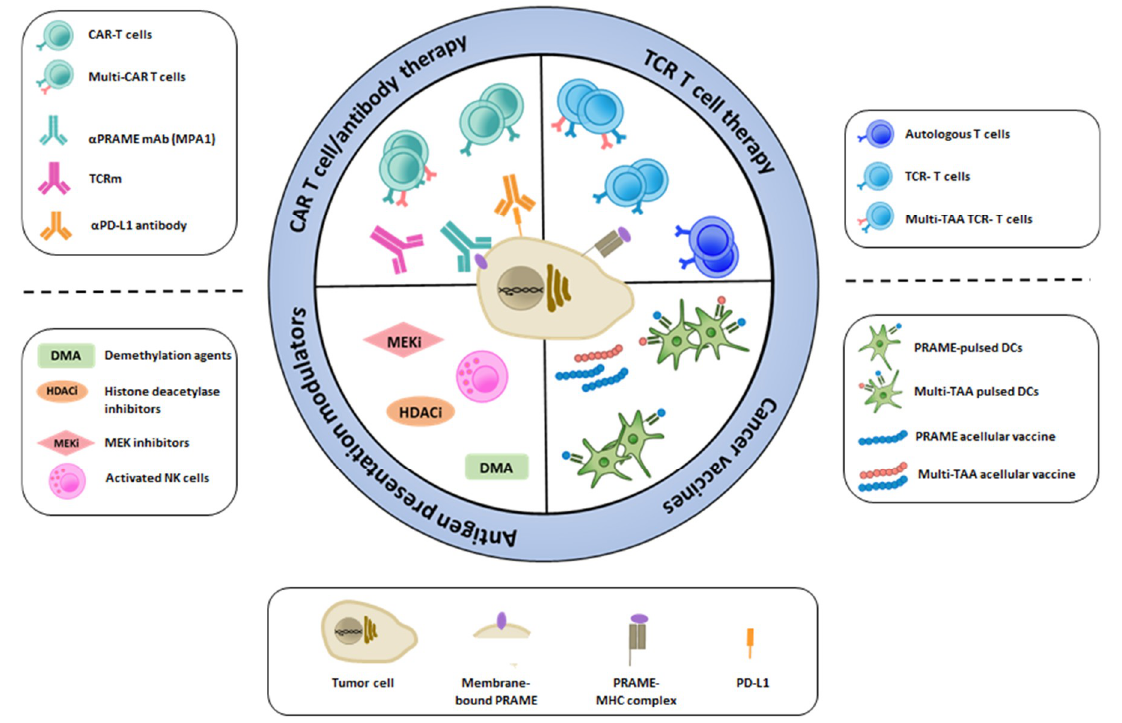
Figure 1. Immunotherapy approaches to target specific tumor-associated antigens such as PRAME.